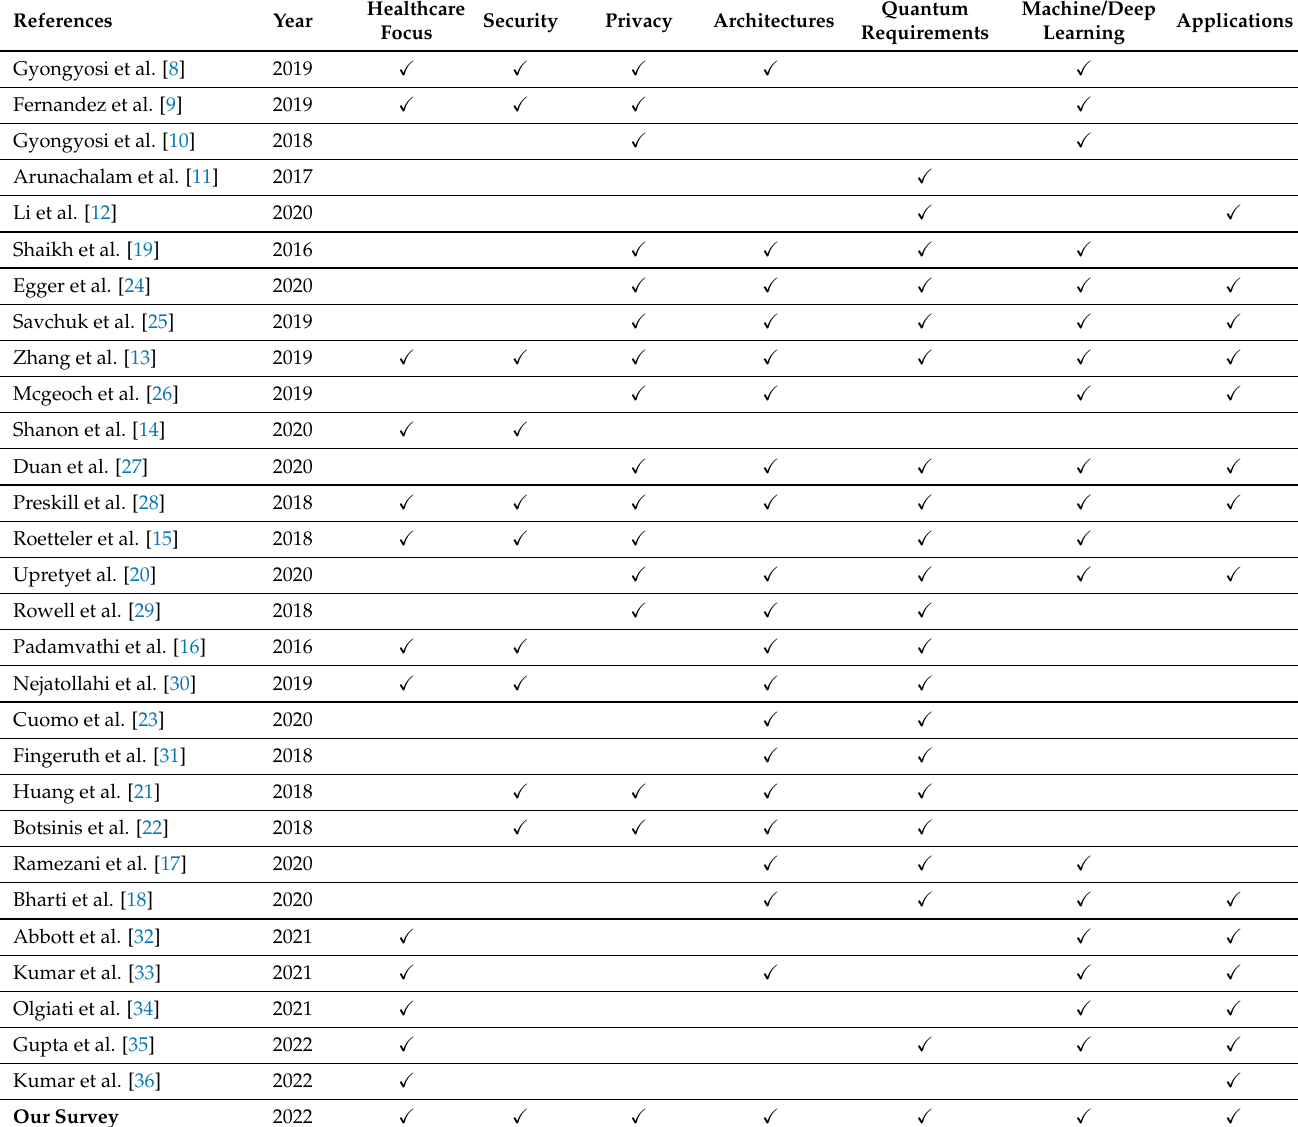
Table 1. A comparison of this survey with related